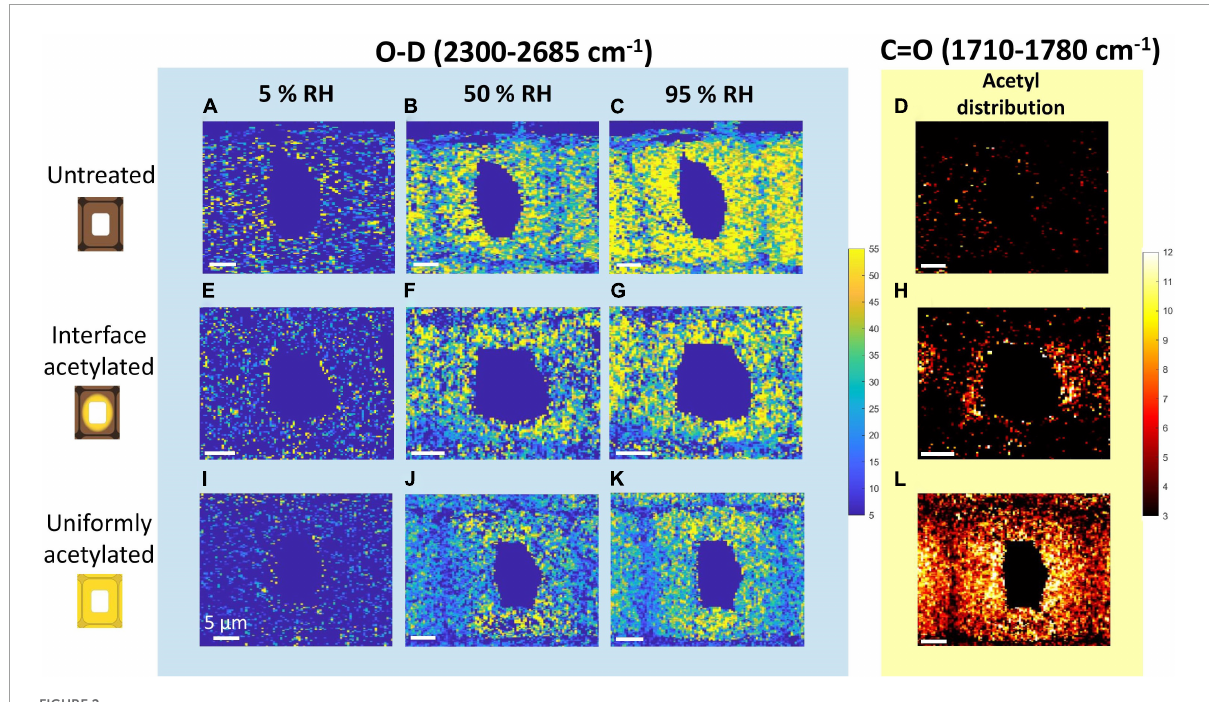
FIGURE2 Intensity maps of the Raman peaks assigned to moisture and acetylation of untreated (A–D) , interface acetylated (E–H) and uniformly acetylated wood (I–L) . The three columns of maps on the left show O-D stretching (2,300–2,685 cm –1 ) intensity scanned at 5% (first column), 50% (second column), and 95% RH (third column). The column on the right shows intensity maps of C=O stretching (1,710–1,780 cm –1 ). For further clarity the backgrounds of the O-D and C=O intensity maps are color-coded as the band in Figure 1 , i.e., respectively, blue and yellow. All the maps of O-D share the same intensity scale, as do all maps of